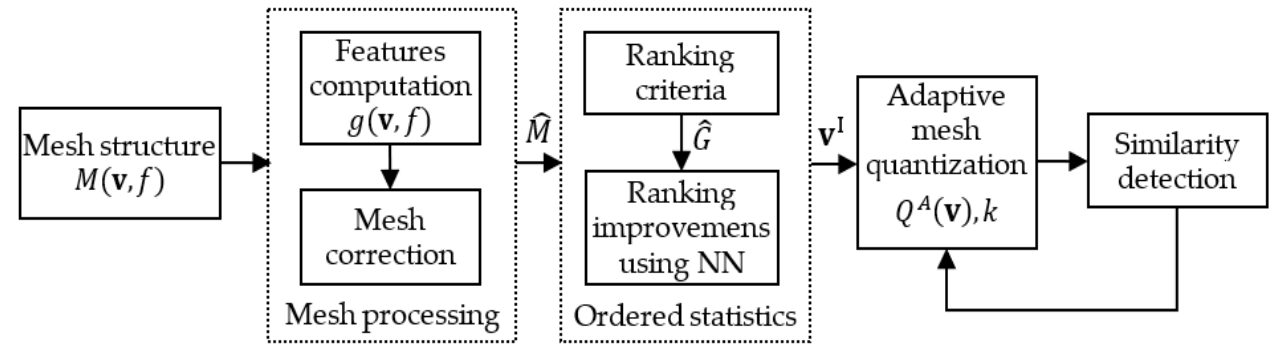
Figure 1. The flowchart of the operations within our algorithm.